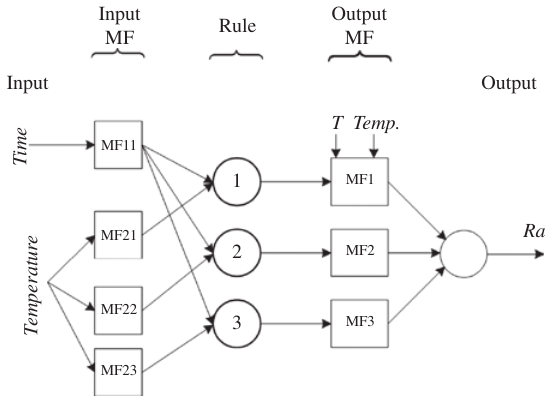
Figure 4 ANFIS structure.